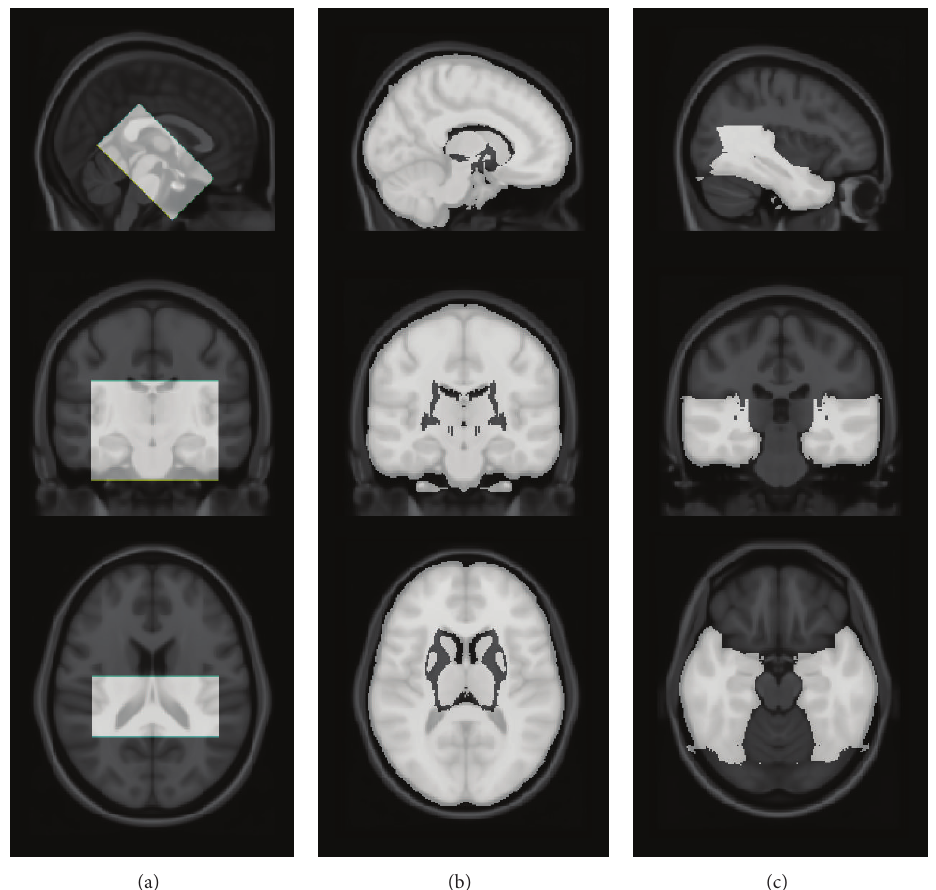
Figure 3: Overview of (a) medial temporal lobe volume of interest; (b) whole brain mask; and (c) temporal lobe volume of